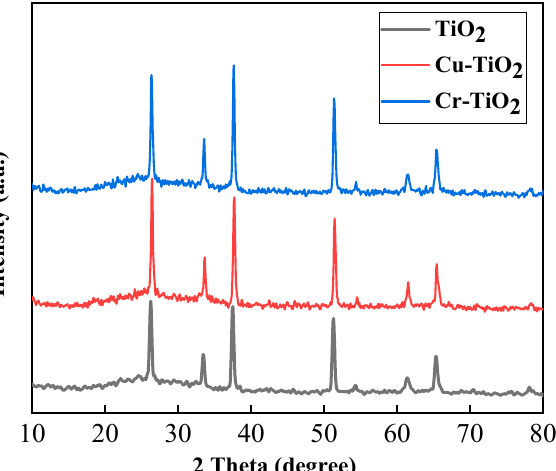
Figure 5. XRD pattern of TiO 2 photoelectrode, Cu-TiO 2 photoelectrode, and Cr-TiO 2